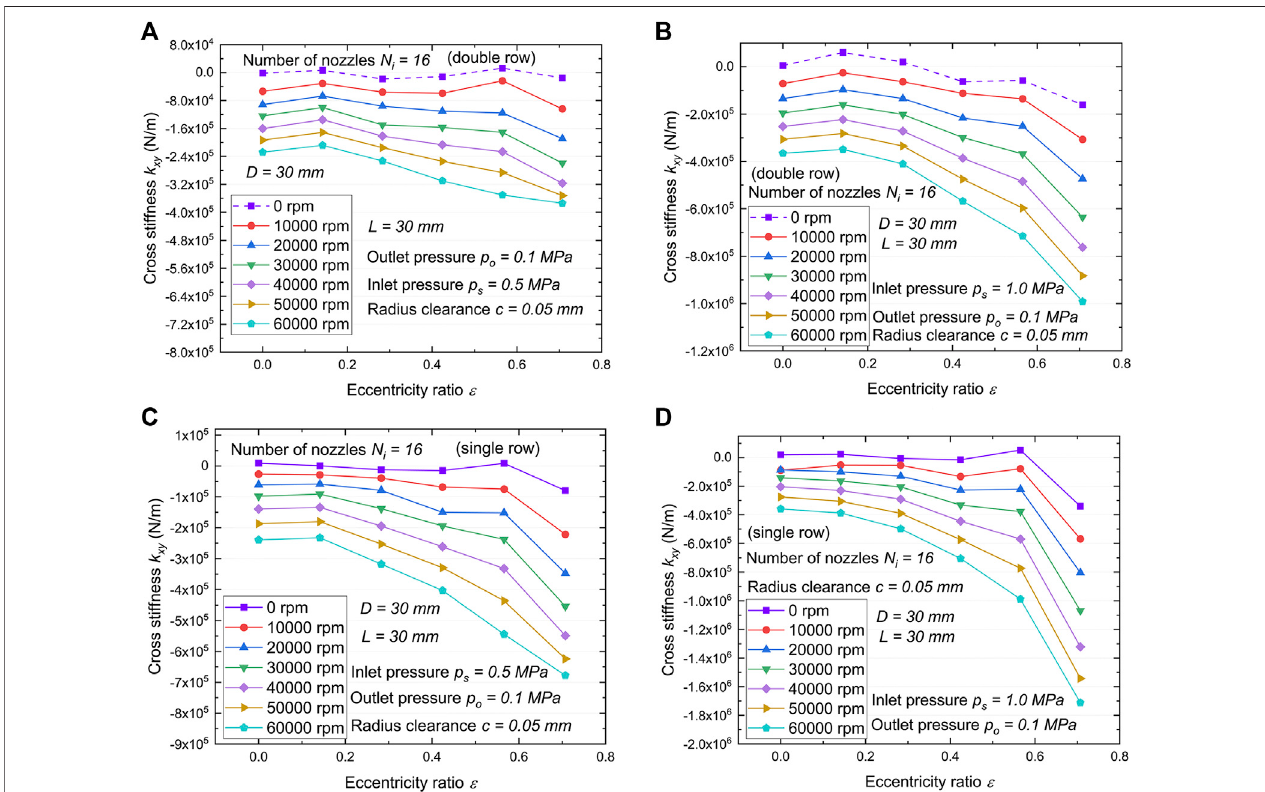
FIGURE10| Variations ofcross stiffnesscoef fi cient k xy witheccentricity ratioversusrotor speed. (A) Double row, p s =0.5 MPa. (B) Double row, p s =1.0 MPa. (C) Single row, p s =0.5 MPa. (D) Single row, p s =1.0